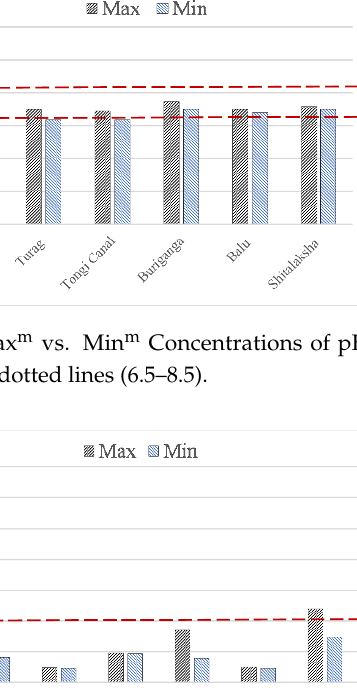
Figure 5. Max m vs. Min m Concentration of BOD 5 in the peripheral rivers of Dhaka with WHO standards (5 mg/L).